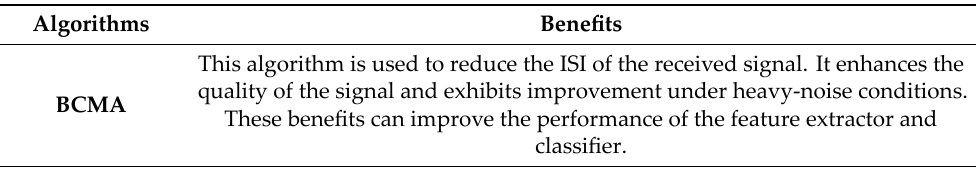
Table 3. Benefits of the proposed algorithm in automatic modulation classification using a feature clustering‑based two‑lane capsule network (AMC2N).